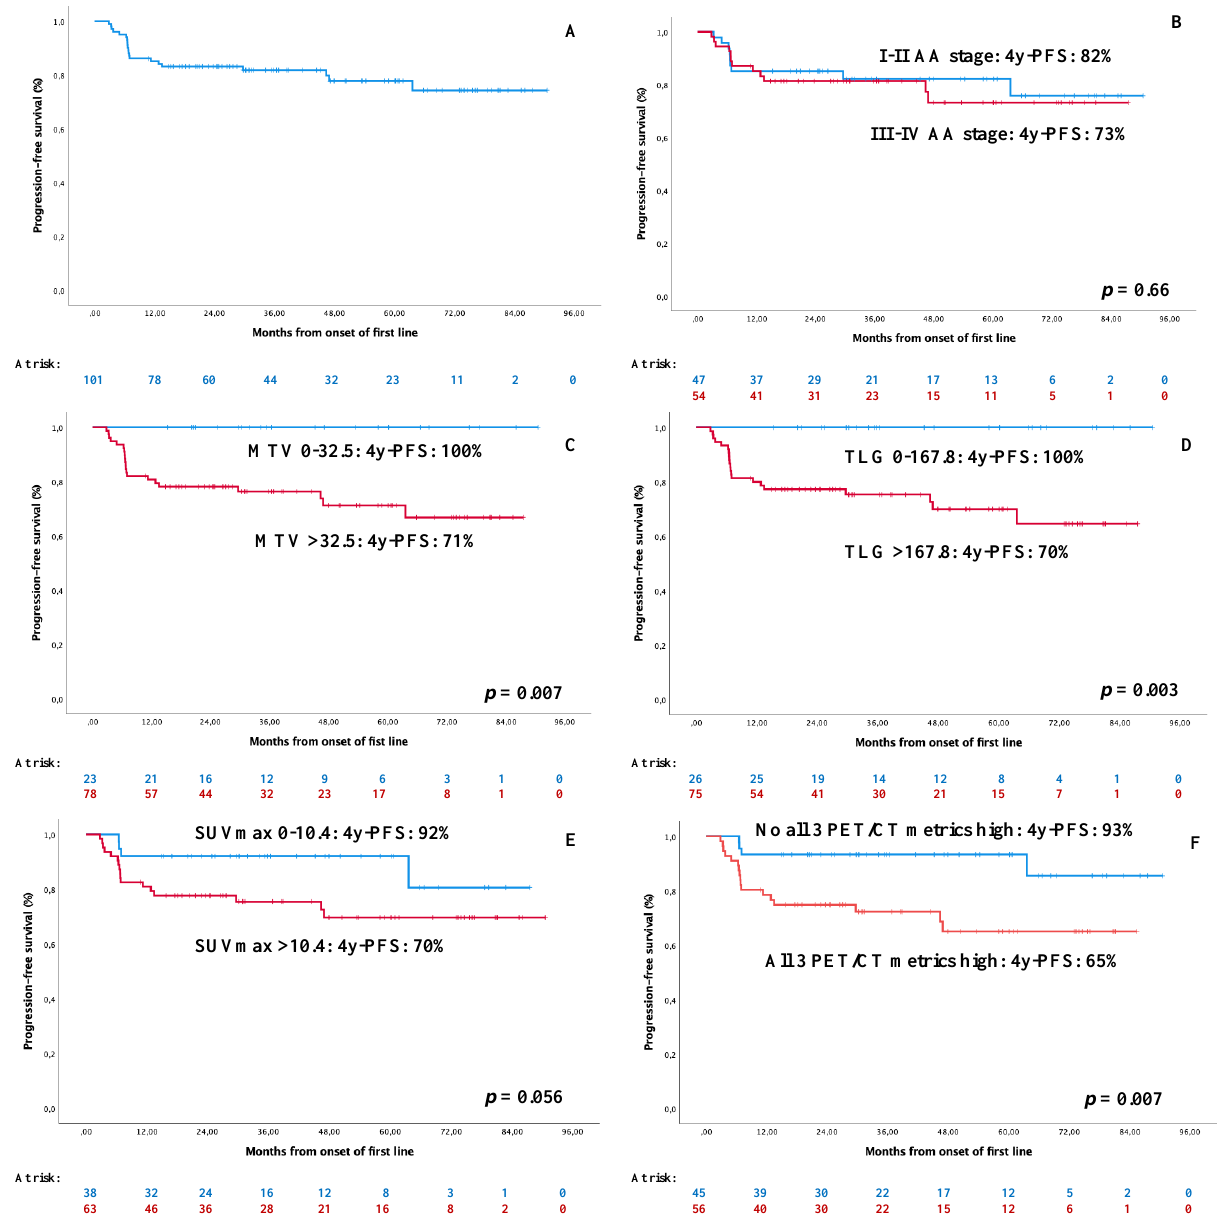
Figure 1. Impact on PFS of standard and PET/CT-related tumor-load assessments. ( A ) PFS of the whole series; ( B ) PFS according to AA staging; ( C ) PFS according to MTV; ( D ) PFS according to TLG; ( E ) PFS according to SUVmax; ( F ) PFS according to all three PET/CT